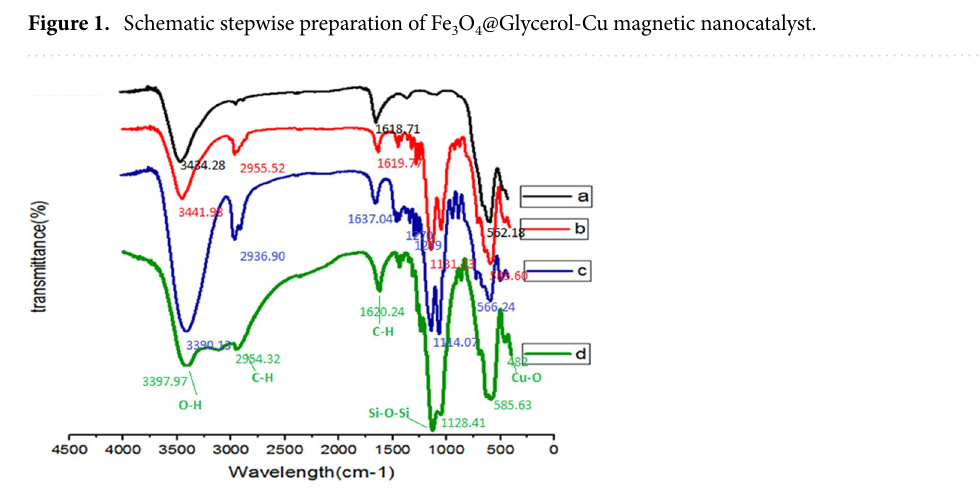
Figure 2. FT-IR spectra of Fe 3 O 4 (curve a ), MNP–(CH 2 ) 3 Cl (curve b ), MNP–(CH 2 ) 3 Cl/Glycerol (curve c ) and MNP–(CH 2 ) 3 Cl/Glycerol-Cu (curve d